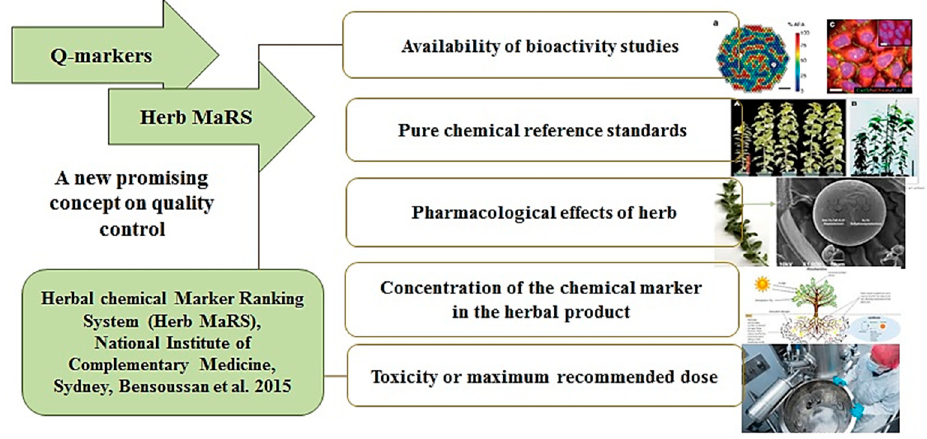
Figure 4. Herb MaRS criteria for chosen of Q-markers for Crocus perianth raw material and crude extracts.